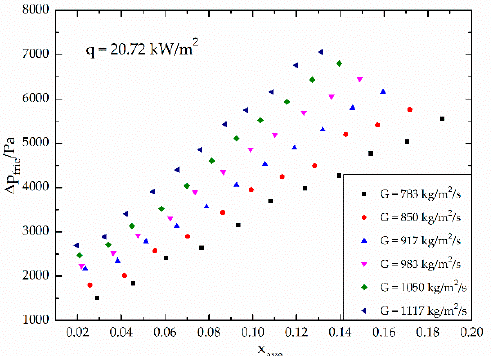
Figure 4. Variation of frictional pressure drop with respect to average vapor quality under different mass velocities.